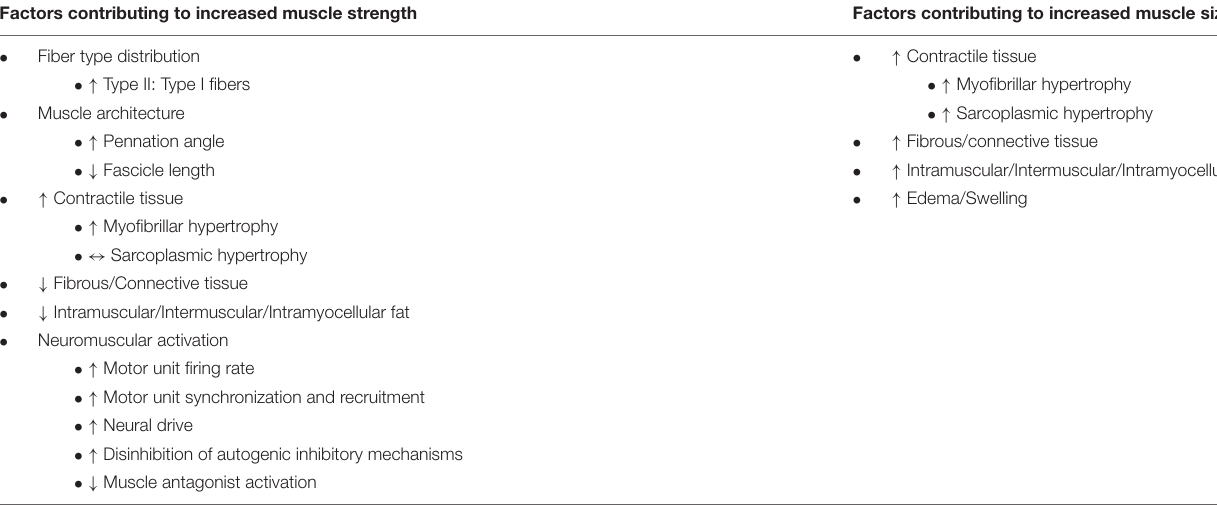
TABLE 1 | Factors contributing to increased muscle strength and size, which are important determinants of MQ. Factors contributing to increased muscle strength Factors contributing to increased muscle